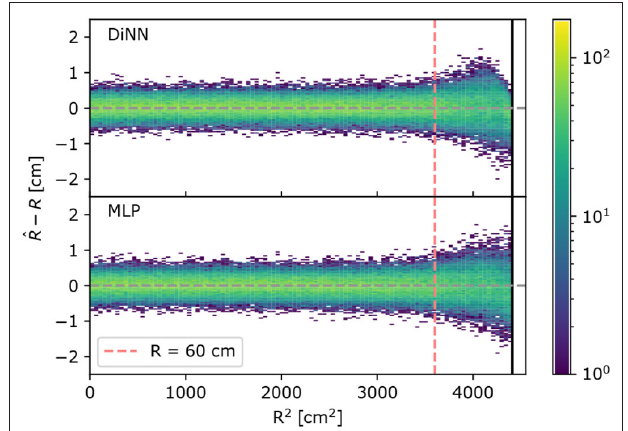
FIGURE 6 | Radial error ˆ R − R on 100 electrons simulated S2s. A positive radial error means the S2 is localized further away from the center of the detector than the true position and vice versa. Both the DiNN and MLP model cannot localize S2s in R > 60 cm region as accurate as S2s in R < 60 cm region, resulting in a wider spread in R > 60 cm region and the positive radial error is suppressed by the constrained output in the region extremely close to the detector wall for the